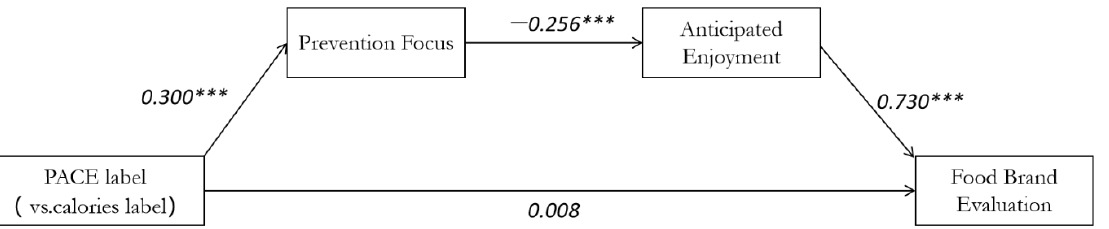
Figure 5. Study1: Mediating effect of prevention focus and anticipated enjoyment between PACE label and brand evaluation. Note: Numbers indicate beta values, and numbers indicate the main effect after adding the mediator variable. * p < 0.05; ** p < 0.01; *** p < 0.001.